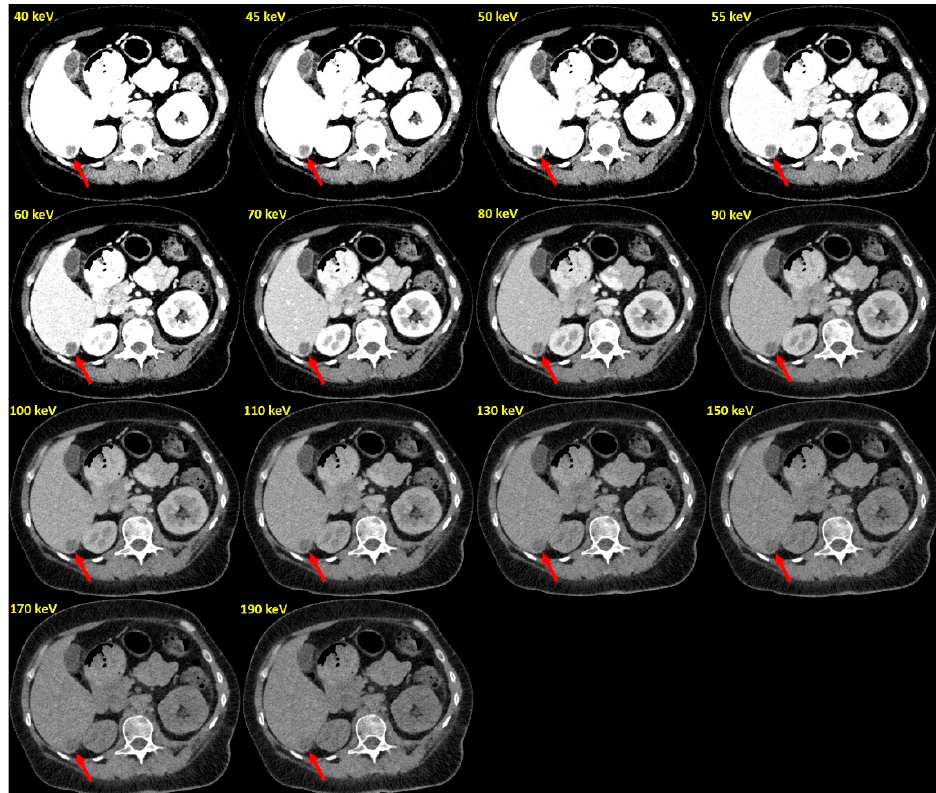
Figure 4. Example of PCD-VMIs (40–190 keV) in a patient with hypovascularized liver metastases of pleura mesothelioma. Hypovascularized metastasis in segment VI (arrow).